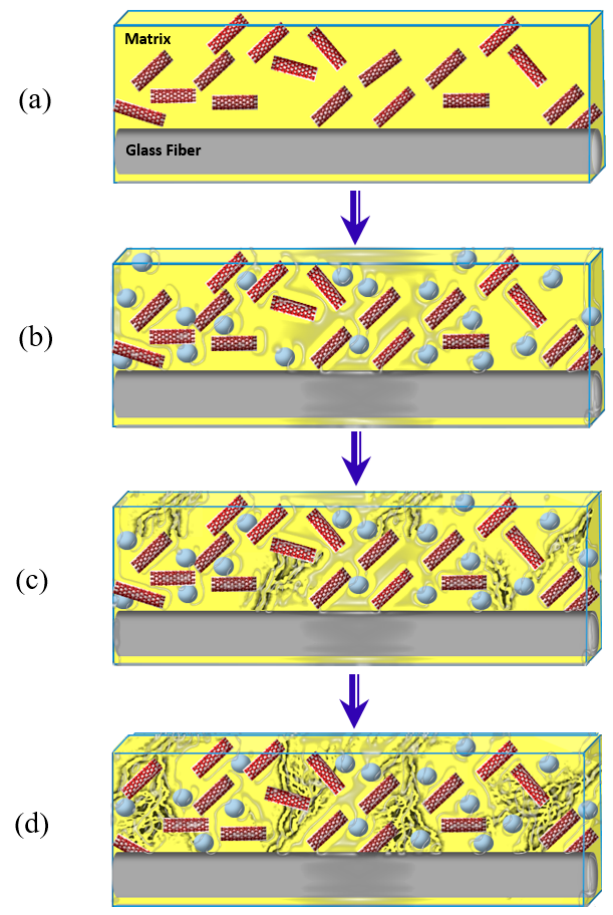
Figure 15. Schematic illustration showing the effect of water pentration of the GFRP composite incorporating carbon nanoparticles. Red lines represent carbon nanoparticles (CNFs or MWCNTs) while white spheres represent water molecules. Black lines represent microcracks as they grow in the epoxy matrix. ( a ) the initial state of the matrix before immersion in water; ( b ) the early stage of the matrix after immersion in water; ( c , d ) late stages of the matrix after immersion in water showing the initiation and propagation of microcracks, respectivly.